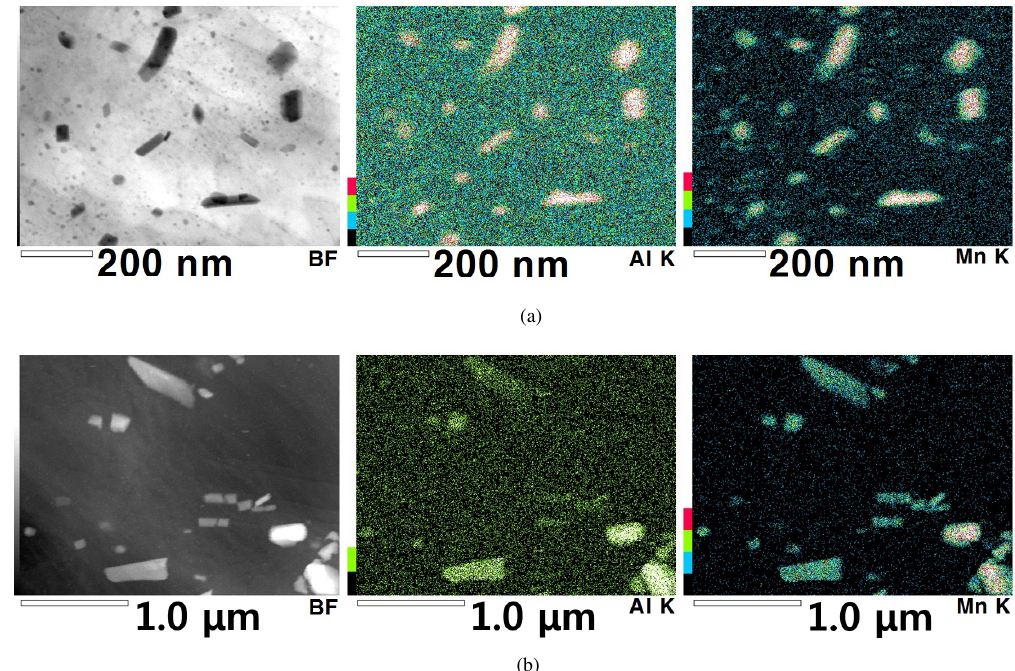
Figure 1. Micrographs of various second phases and their energy dispersive spectroscopy (EDS) results. ( a ) TRC, and ( b )